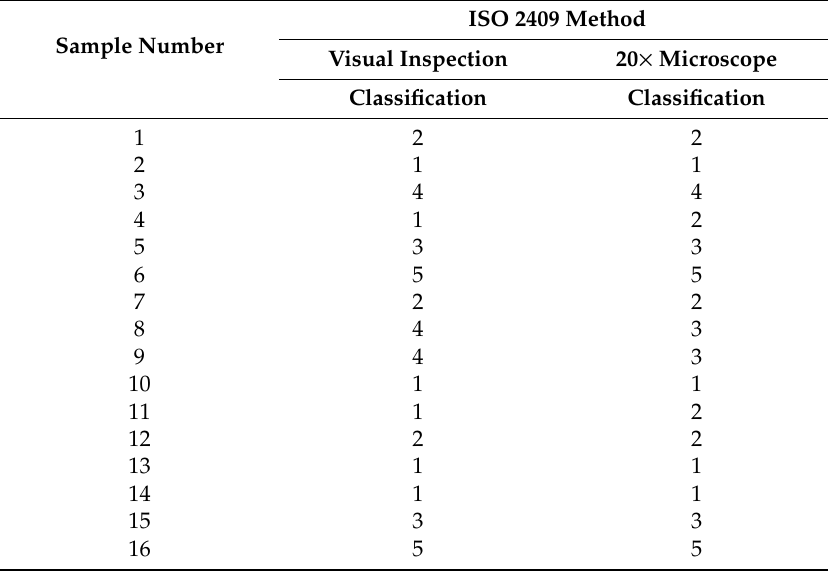
Table 2. Results comparison by visual inspection and microscope observation based on ISO 2409.